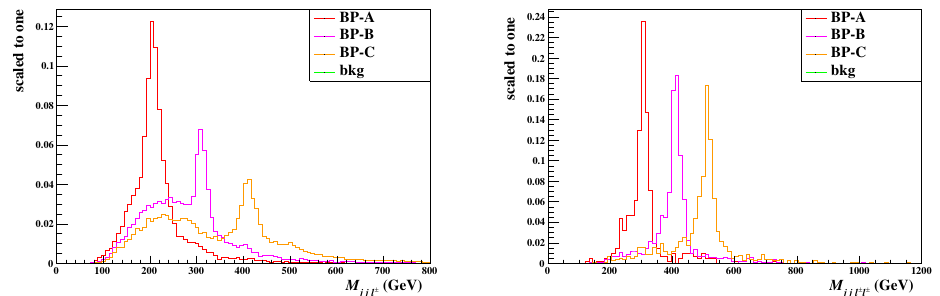
Figure 16 . Same as (cid:12)gure 11, but for the four-lepton